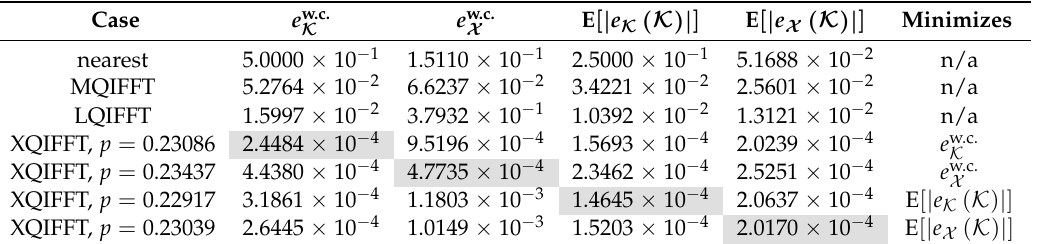
Figure 3. Mean and worst-case for absolute value of errors for the QIFFT method on a length-4096 Hann window, including bin error and detail on bin error, magnitude error and detail on magnitude error. Horizontal lines indicate the worst case and mean errors for the nearest bin, MQIFFT, and LQIFFT methods for comparison. Shaded regions indicate the range of the detail in corresponding figures to the right. The thick lines indicate the XQIFFT. ( a ) Bin error; ( b ) Bin error (zoom); ( c ) Magnitude error (zoom); ( d ) Magnitude error (zoom). Table 1. Comparing e K ( K ) and e X ( K ) for various estimation approaches on a length-4096 Hann window. XQIFFT cases which heuristically minimize worst case and mean error bin and magnitude errors are shown. Numbers are given to five significant figures and minimized values are